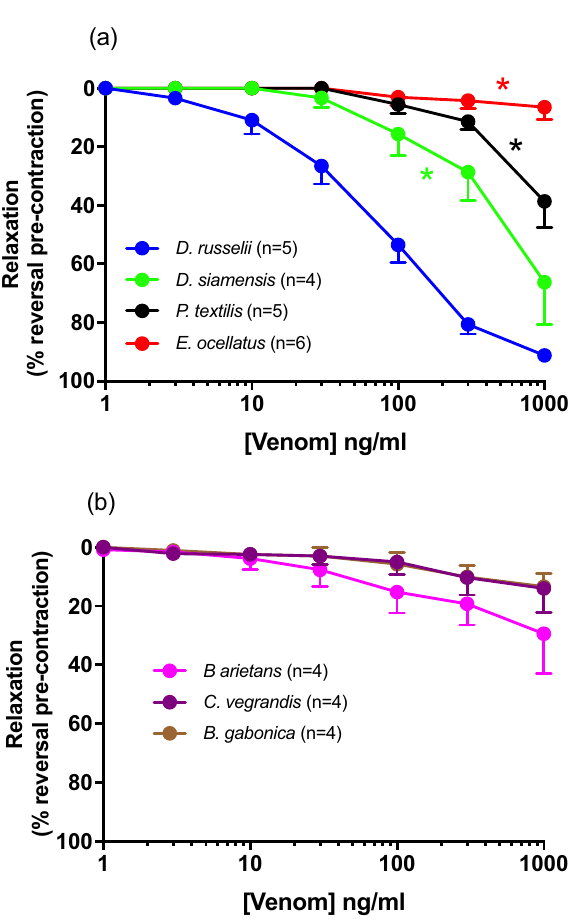
Figure 4. Cumulative concentration-response curves to venom (1 ng/ml − 1 µ g/ml, n = 4–6) in rat small mesenteric arteries. Values are expressed as % reversal of pre-contraction and given as mean ± SEM, where n = number of animals. * P < 0.05, concentration-response curve significantly different as compared to D. russelii